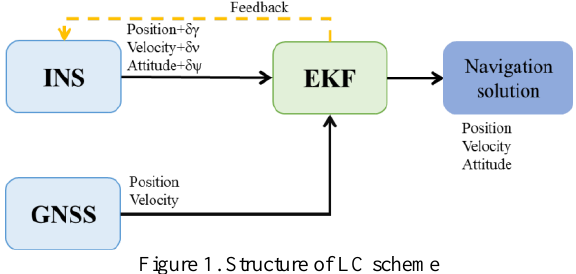
Figure 1. Structure of LC